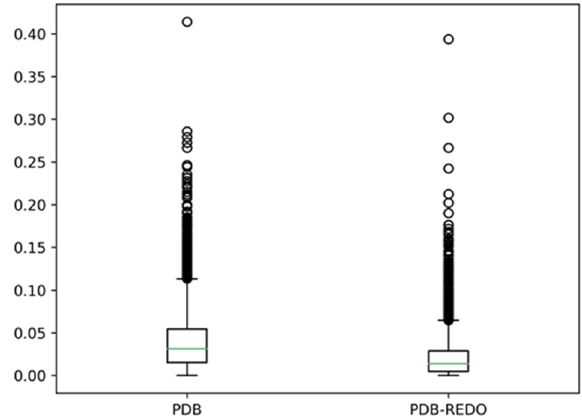
Figure 3. Box and whisker plots for the comparison of DSSP assignment of the A and B chains in covalently identical dimers. (Left) About 7000 dimers found in PDB files; (Right) The corresponding PDB-REDO files. The secondary structure assignments by DSSP are reduced to three states (helix, strand, and rest). Assignments are called different if the assignment character for the residues at equivalent positions in the two chains in the dimer are different.